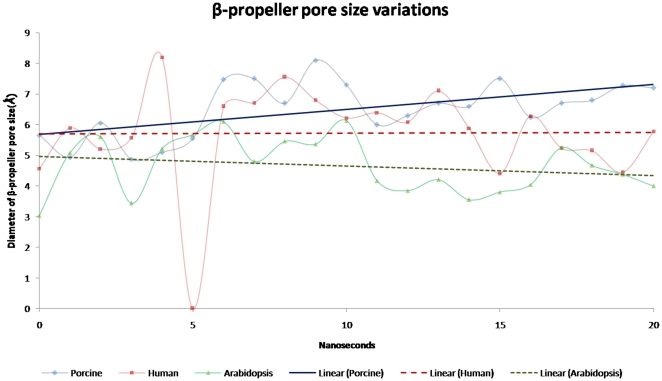
Deviations in β-propeller pore size.During simulation of bound form of porcine, human and A. thaliana POP. In porcine diameter of pore was found to be increasing in while human and A. thaliana it was found to be decreasing (Figure S7 for replicate runs).